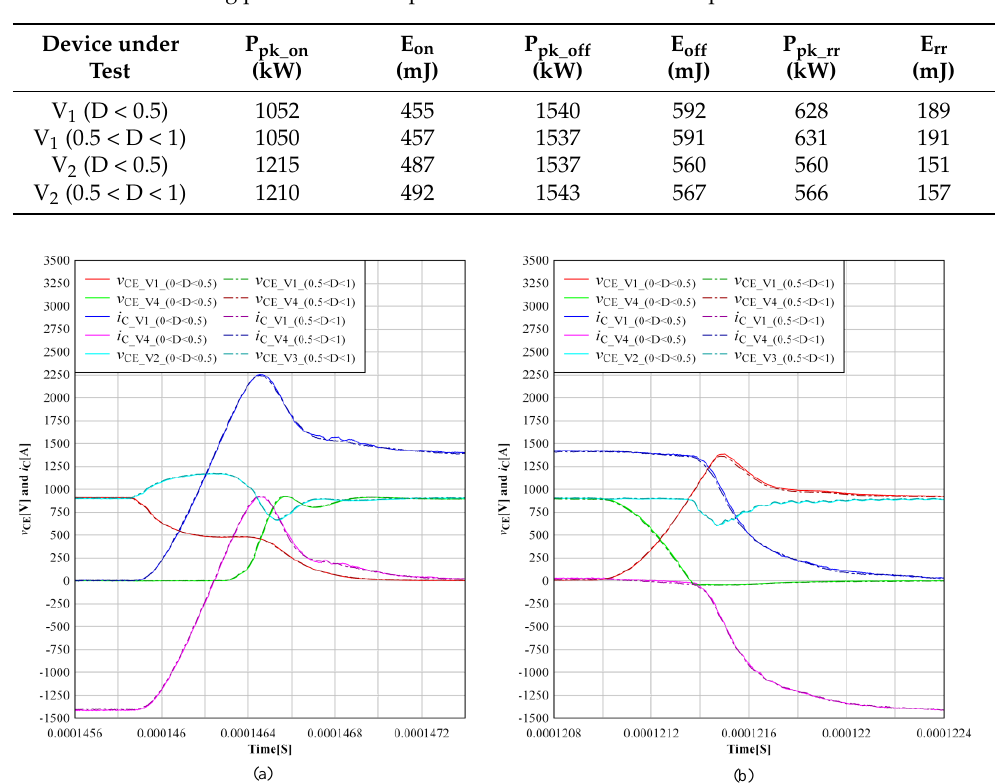
Figure 19. Influence of the current paths of outer commutation loop in buck mode. ( a ) Detail waveforms during IGBT turn-on. ( b ) Detail waveforms during IGBT turn-off.